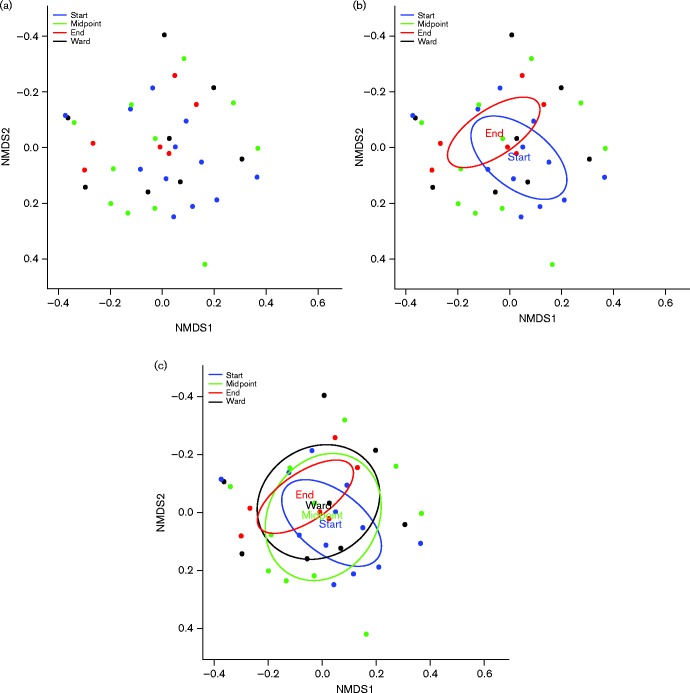
Non-metric multidimensional scaling (NMDS) analysis of grouped dental plaque samples. (a) Scatter representations of dental plaque communities and (b) the grouping, and therefore relationship between dental plaque communities from the start of intubation and at the end of extubation. (c) Overlap of communities at all sample time points.